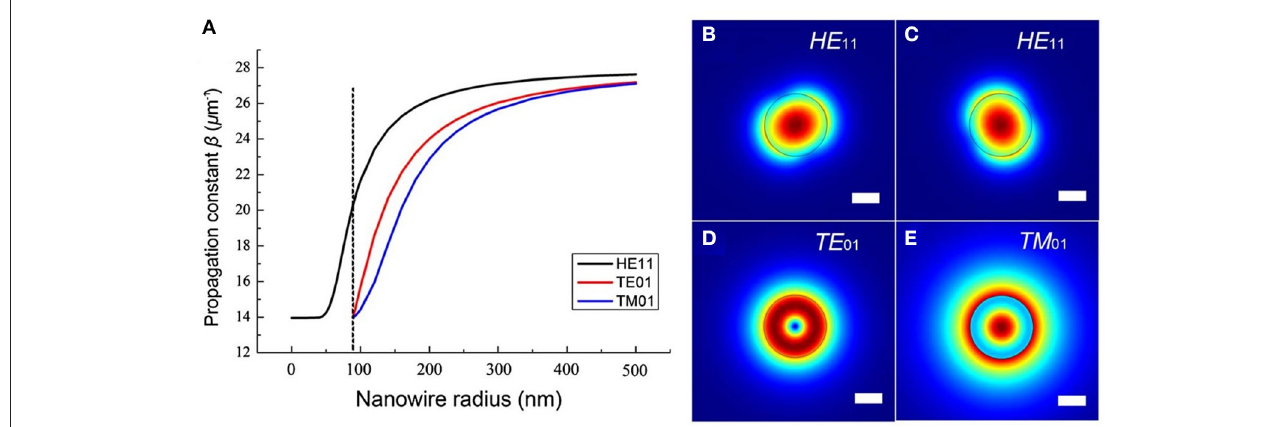
FIGURE 3 | (A) The propagation constant β of the HE 11 , TM 01 , and TE 01 modes as a function of ZnO nanowire radius. Dashed line represents the single-mode condition. (B) Electric field distributions of the HE 11 , TM 01 , and TE 01 modes for ZnO nanowire with 240nm diameter at a wavelength of 420nm. Scale bar: 100nm. (A–E) Reproduced with permission. Ma et al. (2013) Copyright 2013, Optical Society of America.